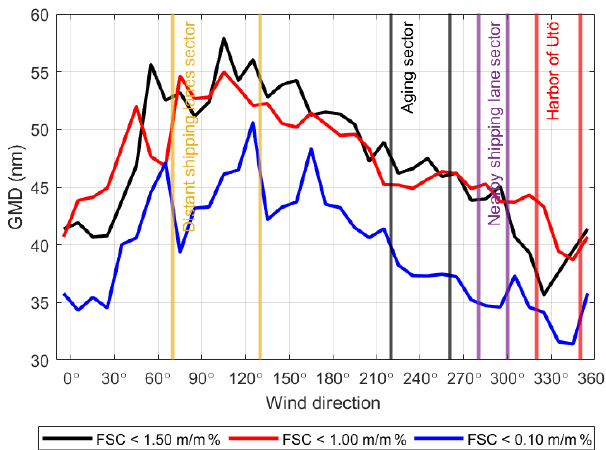
Figure 7. Average geometric mean diameters (GMD) of particles in plumes originating from different directions during the different fuel sulfur content (FSC) restrictions. The distant shipping lanes sector, aging sector, nearby shipping lane sector, and harbor of Utö are marked using pairs of vertical